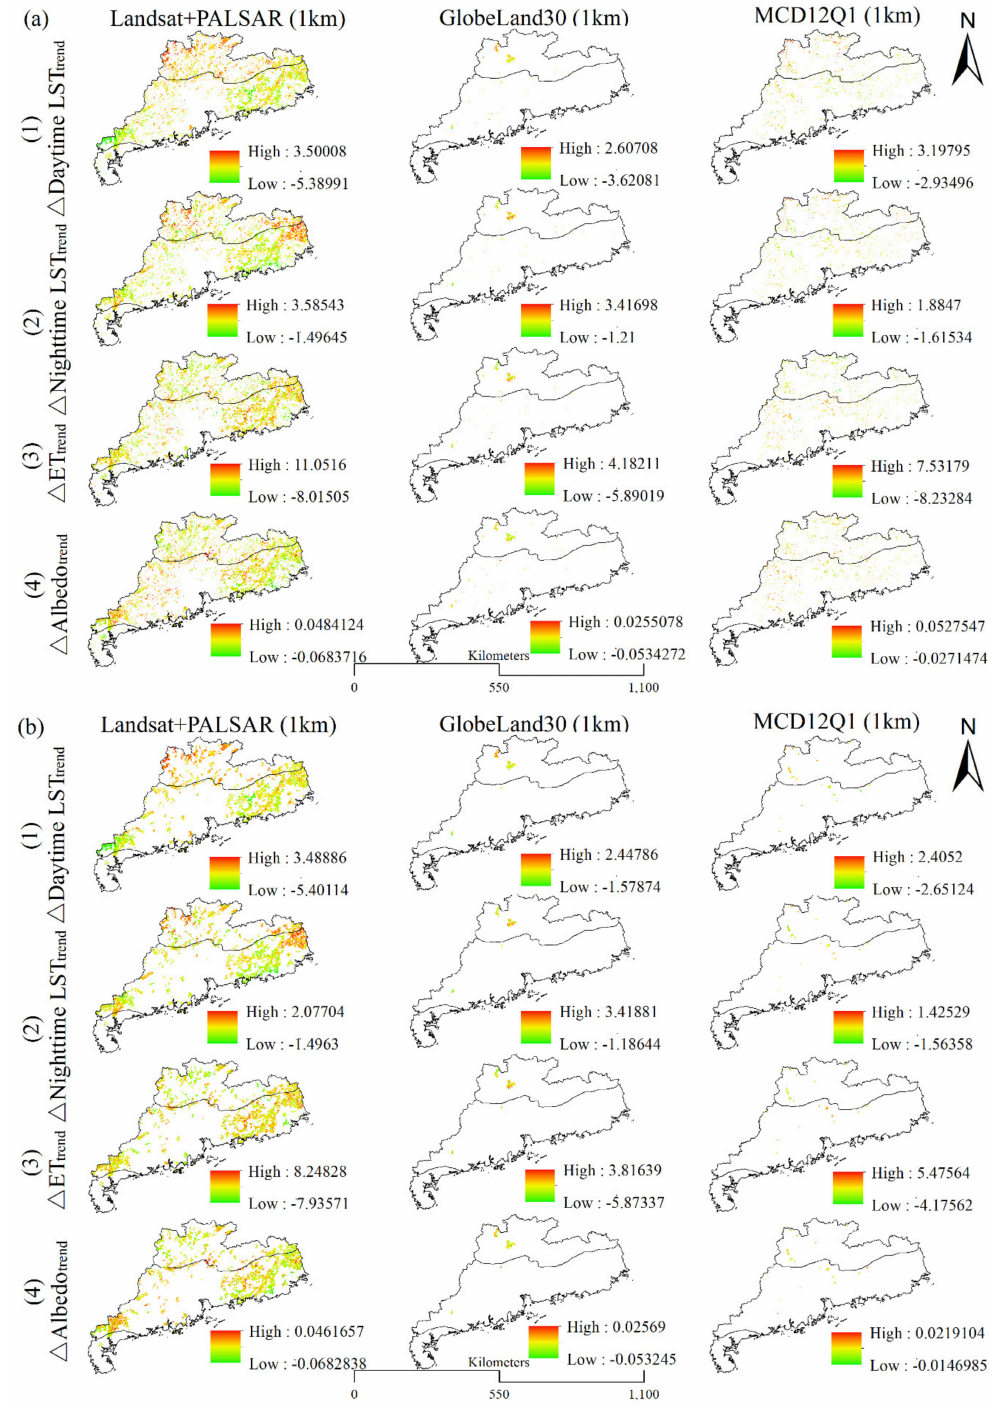
Figure 6. Changes in forest loss and gain areas at 1-km resolution from ( a ) adjusted SCD and ( b ) MCD based on the Landsat / PALSAR, GlobeLand30, and MCD12Q1 datasets (shown in Figure 4) of annual daytime LST, nighttime LST, ET, and albedo in Guangdong Province, China from